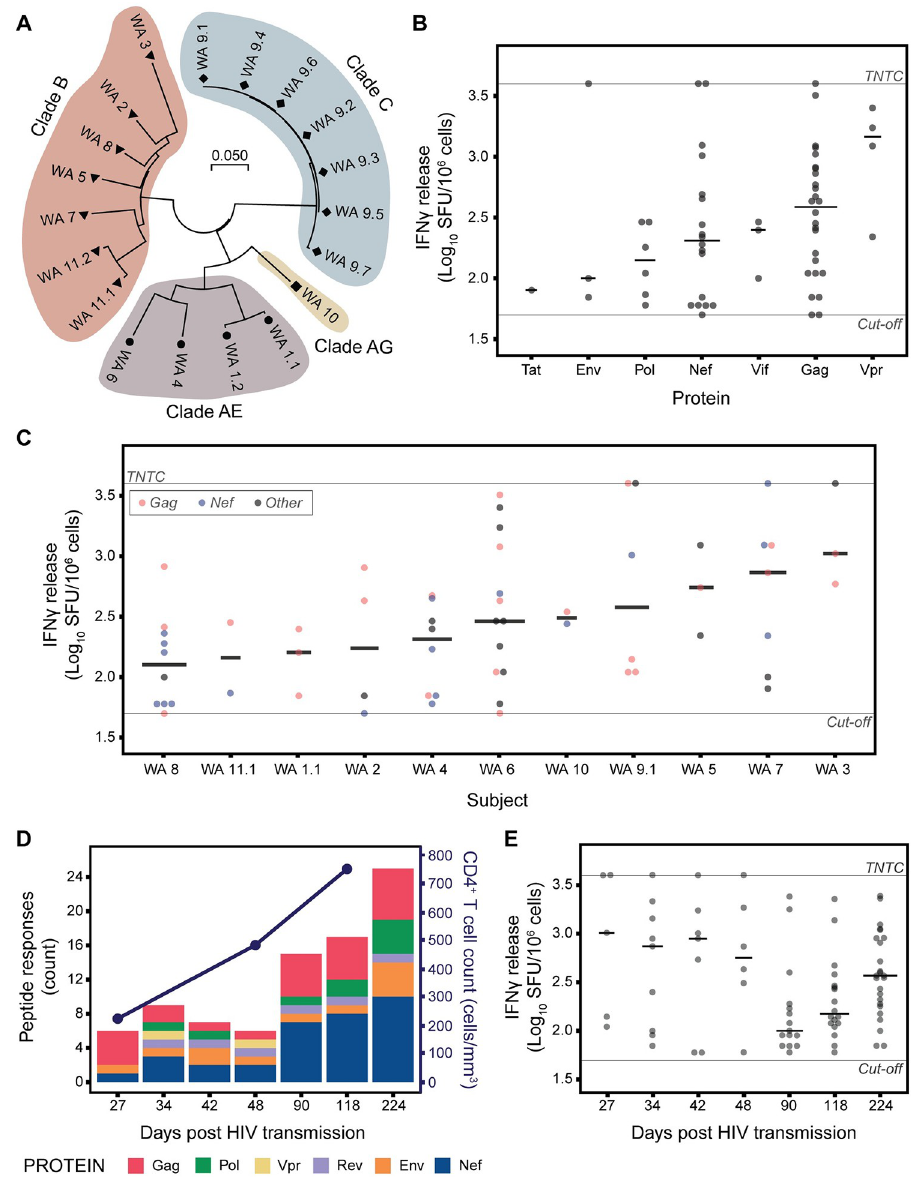
Fig 1. IFN γ responses to HLA-associated HIV-specific CTL epitopes are detected in HIV-1 infected subjects prior to full seroconversion. A) Evolutionary analysis of combined Gag, Pol and Nef consensus sequences for each subject supports infection with clade B for six of the 11 subjects and within subject clustering for longitudinal samples. Phylogenetic tree constructed using the Maximum Likelihood method with the Tamura-Nei model. B & C) IFN γ ELISpot responses for peptides tested on subject PBMCs collected at the earliest sampling date. Protein (B) and subject (C) responses are in ascending order according to median IFN γ release (black lines). D) IFN γ ELISpot responses increase over the course of acute infection in subject WA9 and correspond with improved CD4 + T cell counts. E) Evidence of high magnitude, narrow IFN γ ELISpot responses during the first month post presentation. T cells tested three months post transmission or later exhibit lower magnitude and broad IFN γ responses. TNTC (too numerous to count) denotes upper limit of assay (3.6 log 10 SFU/10 6 cells). Cut-off denotes lower threshold for positive responses (1.7 log 10 SFU/10 6